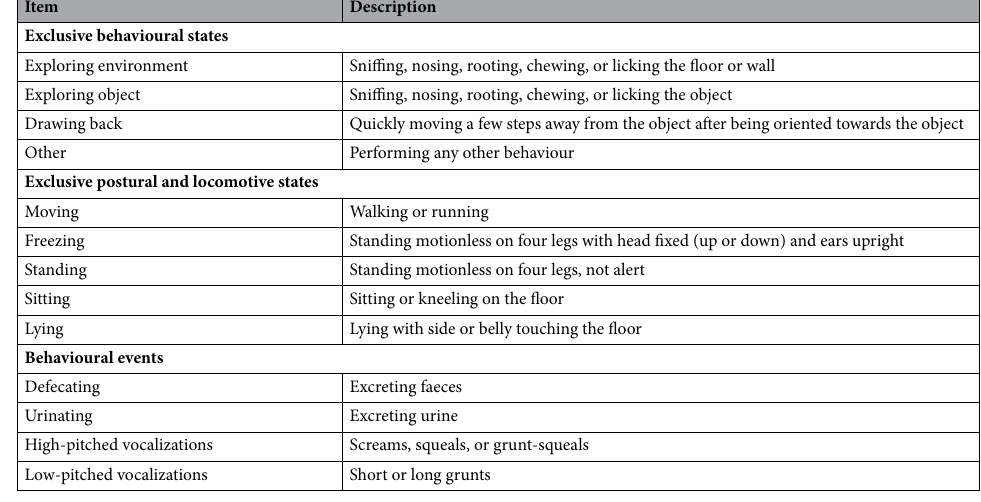
Table 2. Ethogram of behaviours observed in the novel environment test and novel object